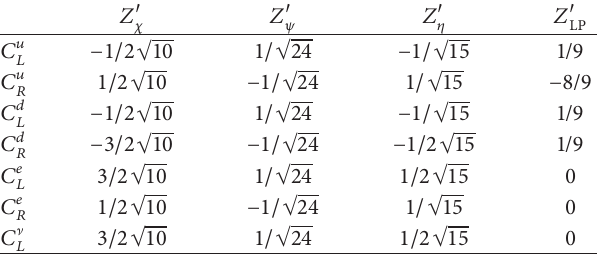
Table 1: The chiral couplings of 𝑍 󸀠 boson with quarks and leptons predicted by different models.